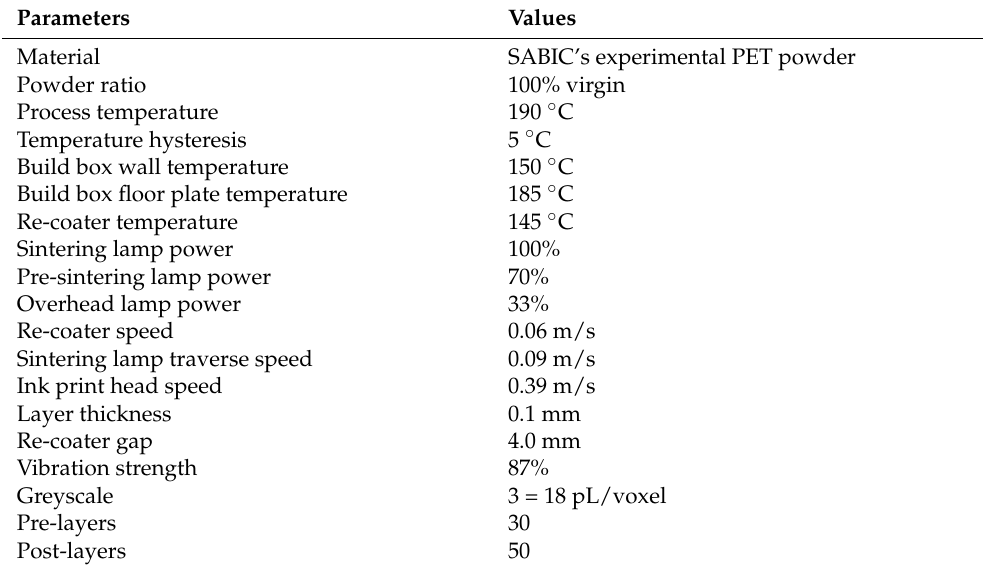
Table 1. Process parameters used for manufacturing PET specimens by